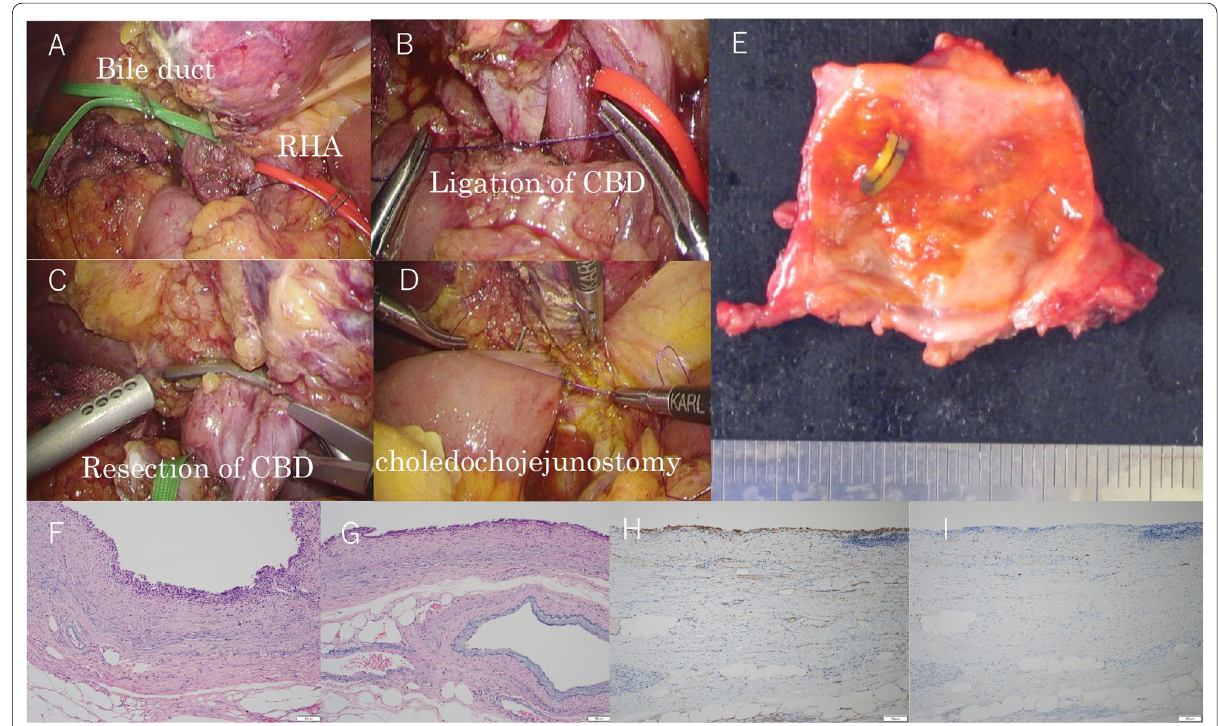
Fig. 4 Intraoperative and postoperative findings for case 2. A – D Images show a laparoscopic bile duct resection and reconstruction. E An NAPC is shown inside the tumor. F , G Victoria blue–hematoxylin and eosin staining indicates erosion of the bile duct, fibroblast proliferation, and inflammatory cell infiltration. H α-SMA staining shows positive expression. I Desmin staining was positive expression